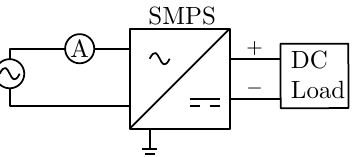
Figure 3. Schematic presentation of the experimental